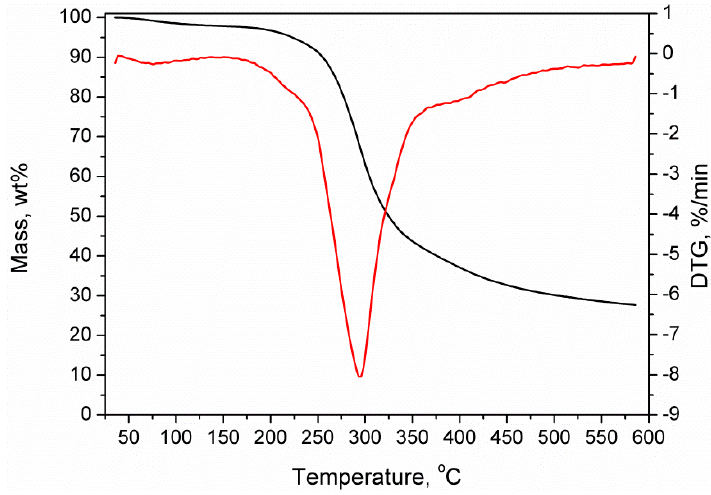
Figure 1. Results of the thermogravimetric analysis of applied wheat bran Figure 1 . Results of the thermogravimetric analysis of applied wheat bran filler.